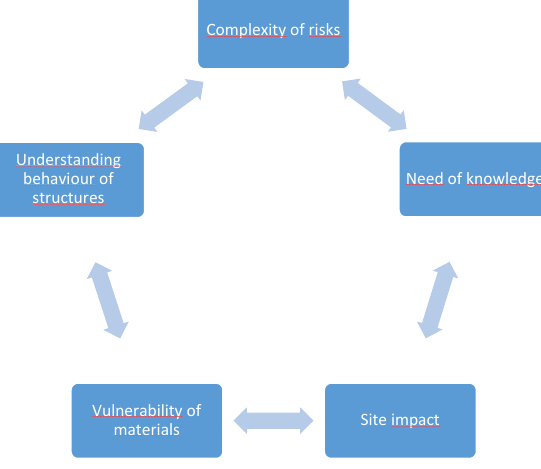
Figure 1. Elements having an impact on a practical-based model.